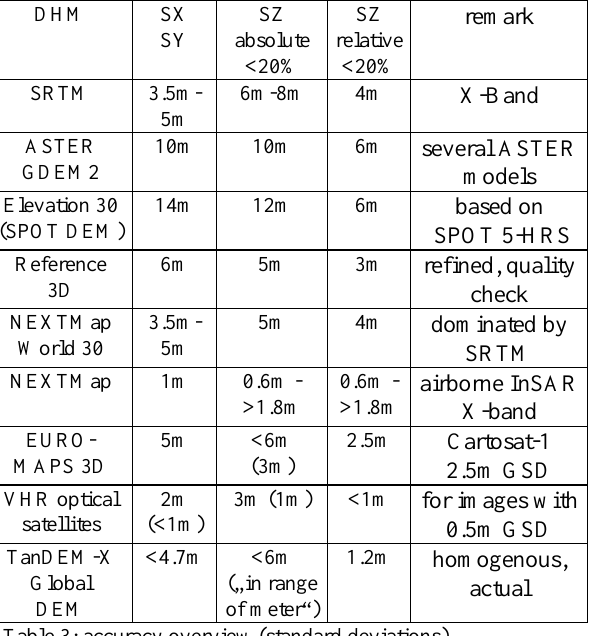
Table 3: accuracy overview (standard